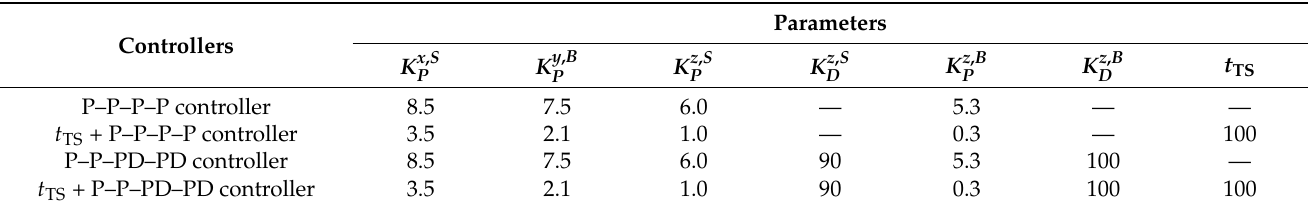
Table 1. Parameters of each